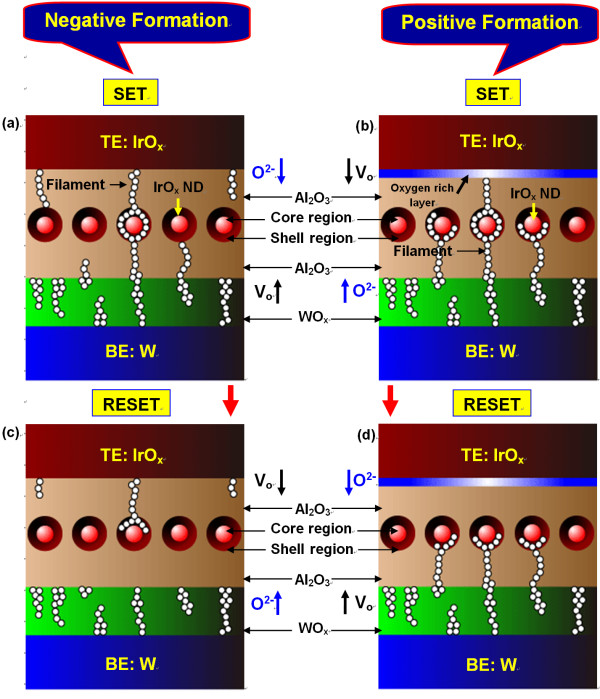
The schematic illustration of the switching mechanisms of NF and PF devices. Schematic illustration of the switching mechanisms of (a) the NF devices and (b) the PF devices under set operation, (c) the NF devices and (d) the PF devices under reset operation.